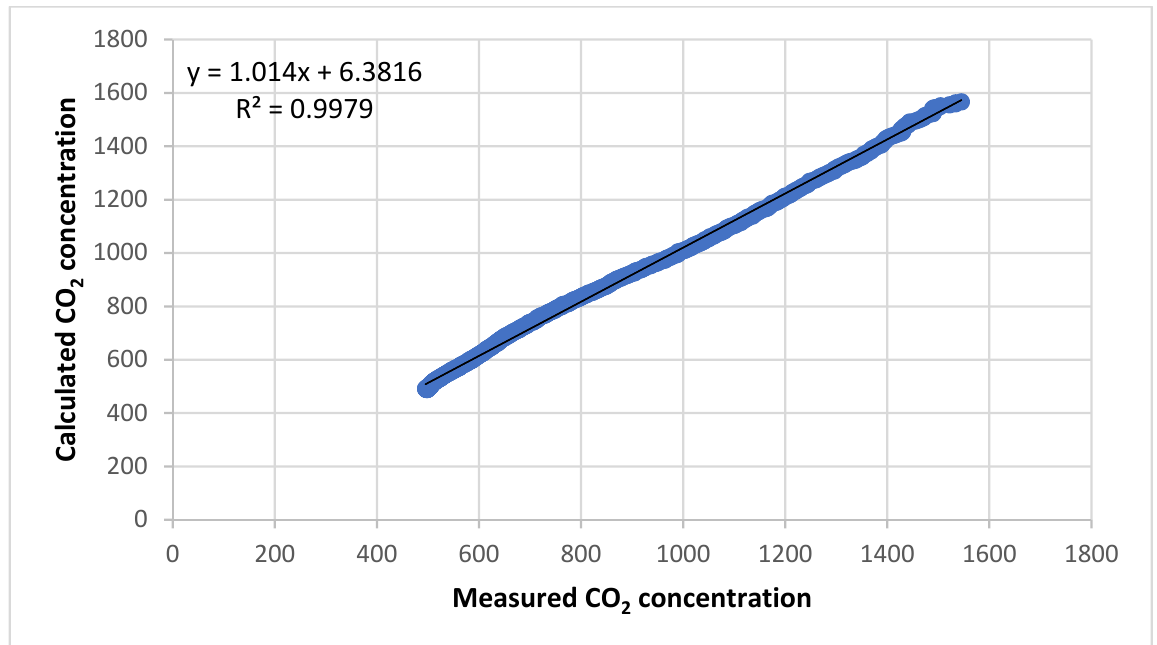
Figure 17. Rate of decrease in CO 2 concentration.